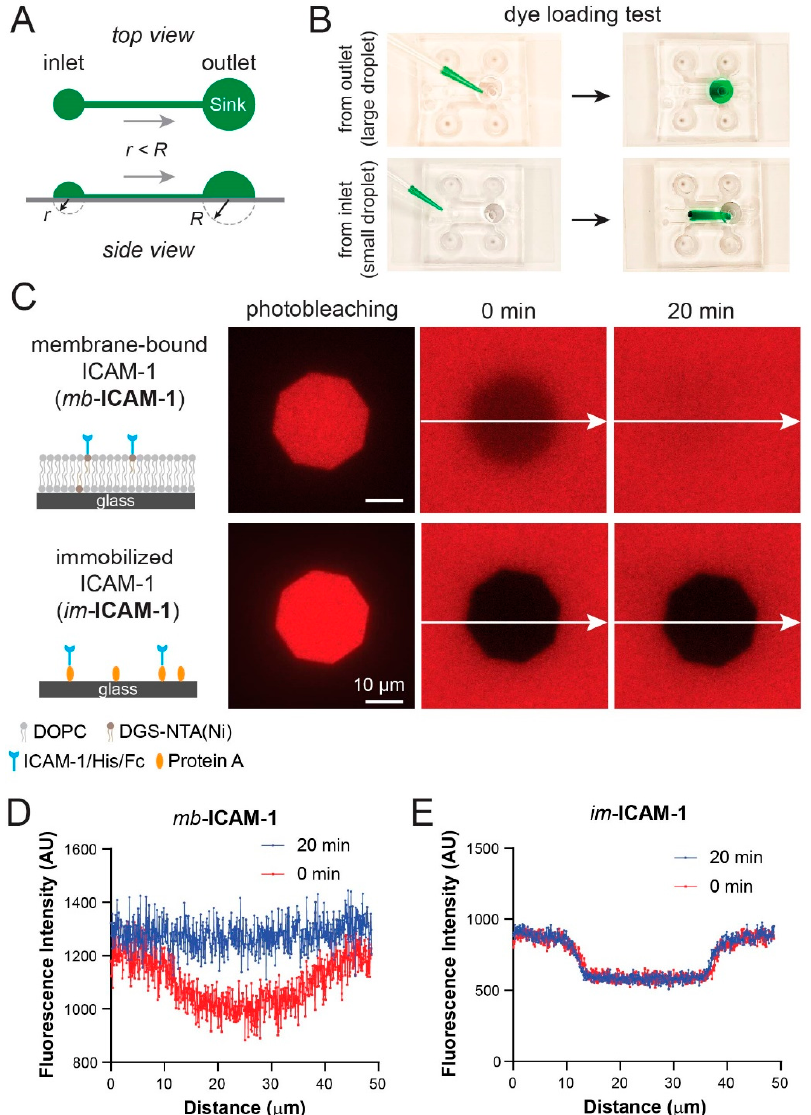
Figure 5. Lipid bilayer formation and confirmation of lateral mobility of the membrane-bound ICAM-1. ( A ) Schematic of filling the center channel with Laplace pressure. R and r are the radii of the larger and smaller droplets, respectively. The difference in pressure generated by the surface tension of each droplet drives liquid movement in the microchannel. ( B ) Dye loading test showing the filling direction. ( C ) Evaluating lateral mobility of membrane-bound (mb-) and immobilized (im-) ICAM-1 with fluorescent recovery after photobleaching (FRAP). ( D,E ) Line scan of mb-ICAM- 1 and im-ICAM-1 fluorescence profiles right after vs. 20 min after photobleaching. We then injected an aqueous solution containing small unilamellar vesicles (SUVs) composed of synthetic lipid 1,2-Dioleoyl-sn-glycero-3-phosphocholine (DOPC) mixed with 5% 1,2-dioleoyl-sn-glycero-3-[(N-(5-amino-1-carboxypentyl)iminodiacetic acid)succinyl] (nickel salt) (DGS-NTA(Ni)) lipid into the center channel of a prepared device to form an SLB. We loaded 6-histidine- and Fc-tagged, fluorescently-labeled intercellular adhesion molecule-1 (ICAM-1) to the channel to tether ICAM-1 to SLB through Ni-chelation. As an immobilized control, we also coated a channel with Protein A and immobilized the same ICAM-1 through the capture of Fc domain by the Protein A layer (Figure 5C). Fluorescence recovery after photo-bleaching (FRAP) technique was